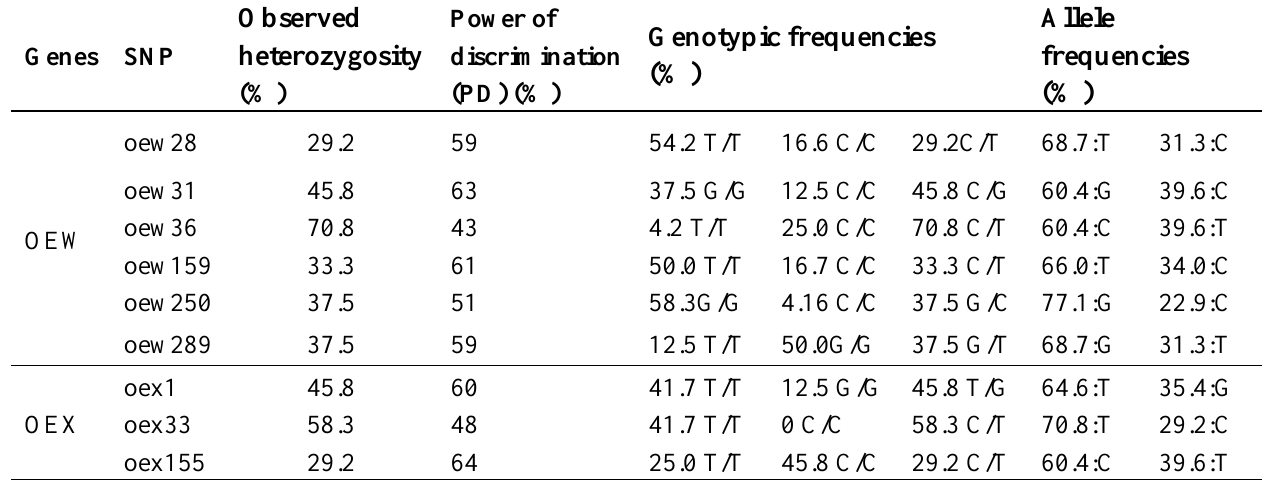
Table 2. Feature and frequencies of the new